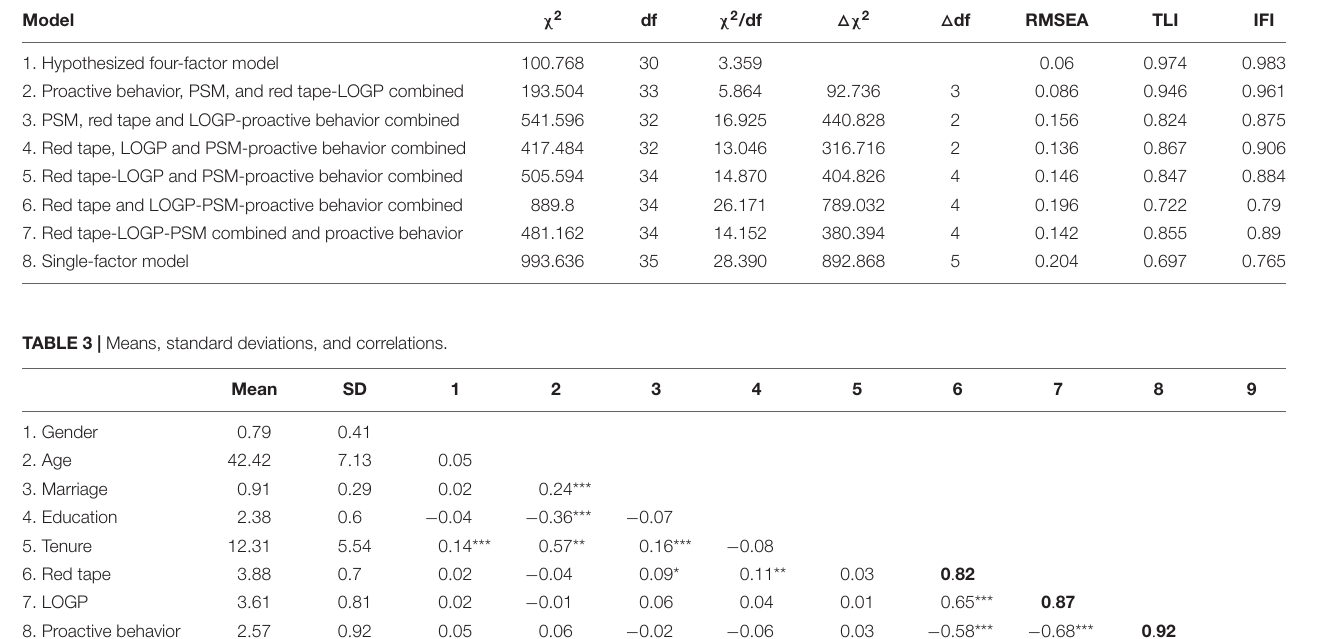
TABLE 2 | Results of confirmatory factor analyses.